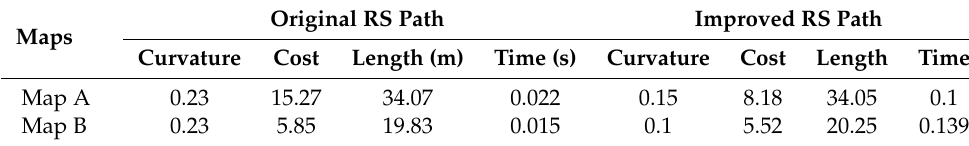
Table 1. Comparison of original and improved methods.